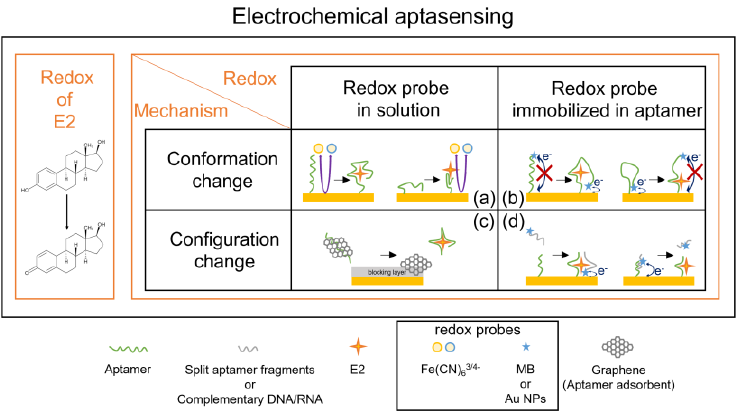
Figure 5. Classification of estradiol aptasensors based on the aptamer and redox probe behaviors. ( a ) Impedance change by the aptamer conformation change. Examples of impedance increase (left) and decrease (right) are shown. ( b ) Change in the redox current by the aptamer conformation change. Examples of the current increase (left) and current decrease (right) are shown. ( c ) Change in redox current by the configuration change in aptamer complex (formation or decomposition). An example of current increase by graphene current channel formation is shown. ( d ) Change in the redox current by the configuration change in the aptamer complex. Examples of split aptamer binding (left) and complementary DNA/RNA decomposition (right) are shown.